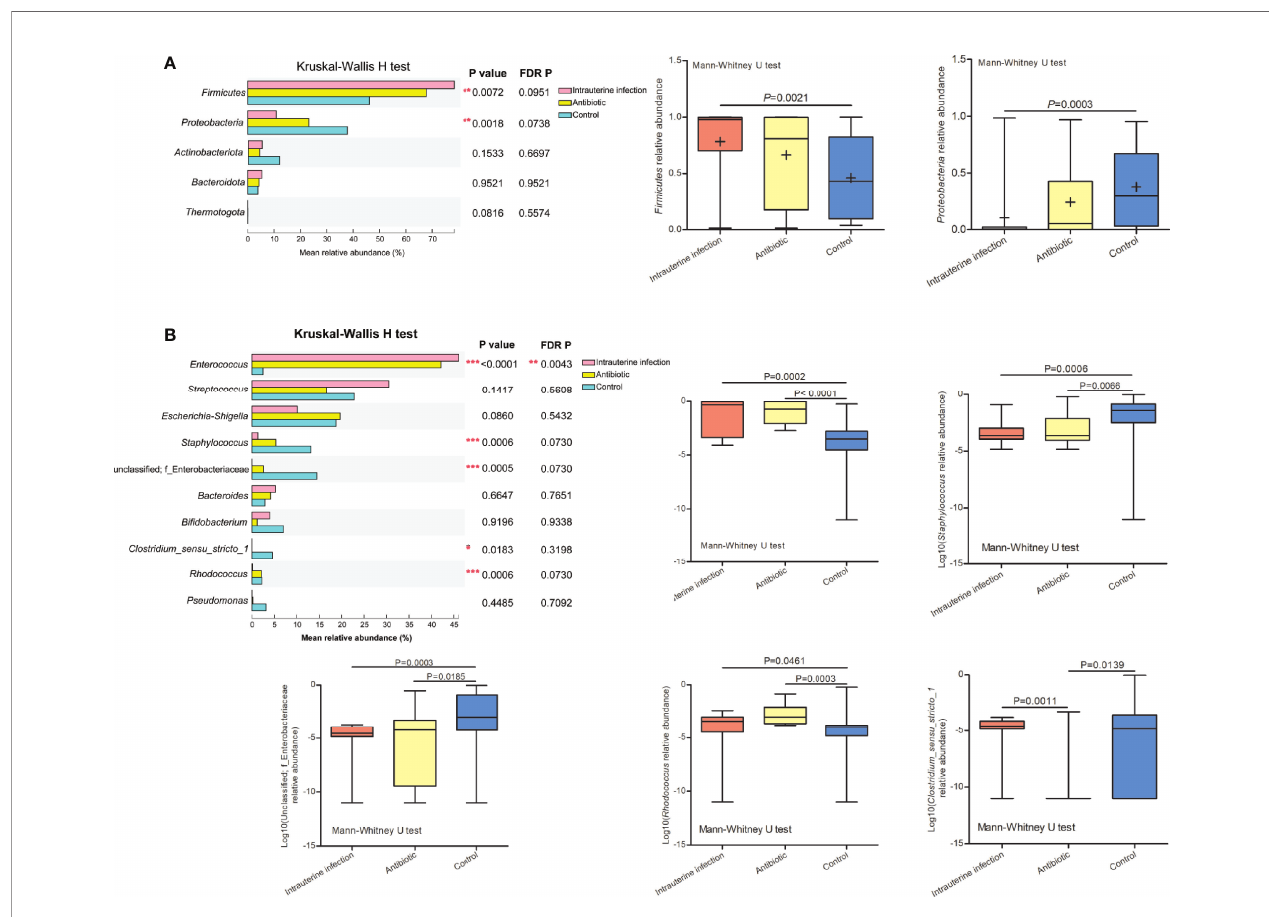
FIGURE 2 | (A) Relative abundance of the top fi ve phyla among the three groups, and the signi fi cantly different phyla among the three groups. (B) Relative abundance of the top ten genera among the three groups, and the log 10 relative abundance of signi fi cantly different genera among the three groups. “ * ” means P or FDR-adjusted P values smaller than 0.05; “ ** ” means P or FDR-adjusted P values smaller than 0.01; “ *** ” means P or FDR-adjusted P values smaller than